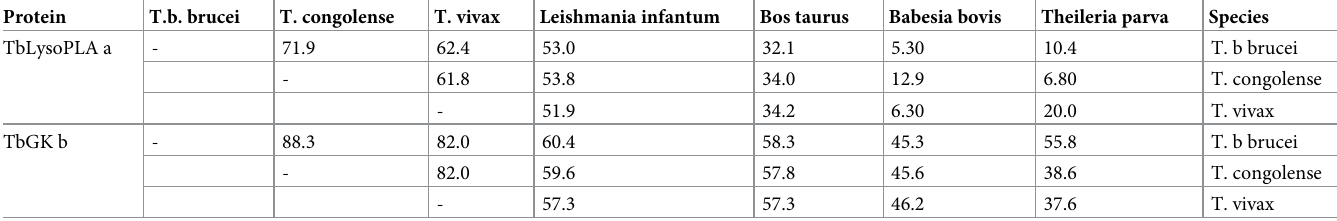
Table 1. Percentage of homology of TbLysoPLA and TbGK and their orthologs.